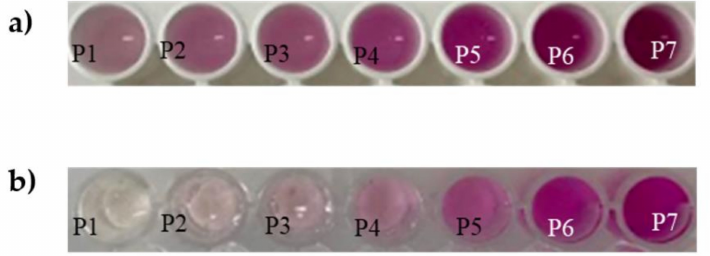
(from 0.01 mg L − 1 to 2.7 mg L − 1 ) 2